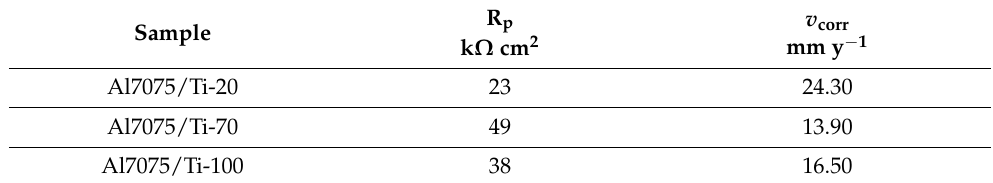
Table 4. Polarization resistance and corrosion rate of titanium coatings onto Al7075 substrate.